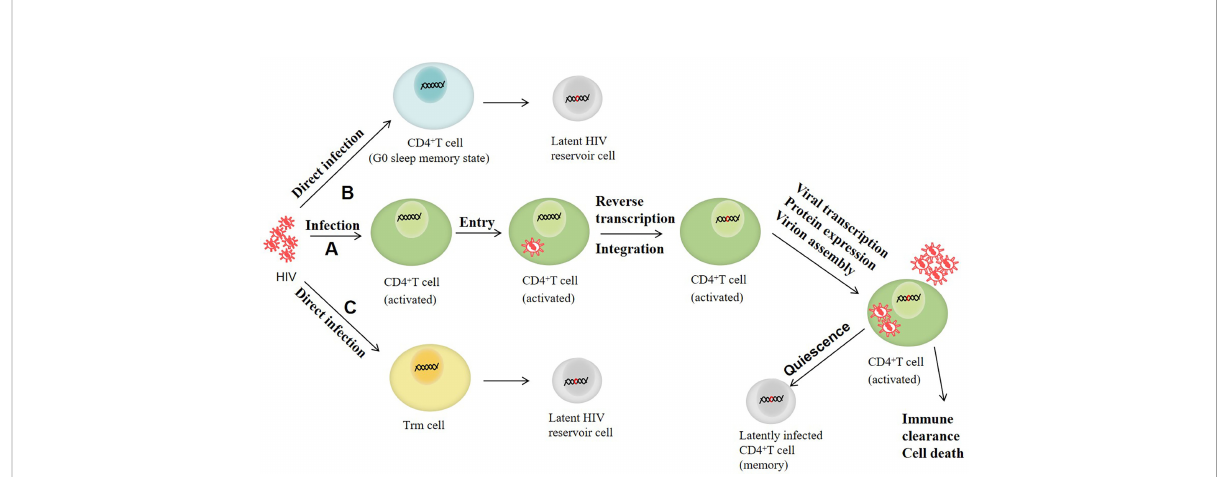
FIGURE 1 The formation process of latent HIV reservoir. (A) HIV mainly infects human CD4+T lymphocytes. When it enters the cell, the RNA is fi rst reversely transcribed into HIV DNA, which is then incorporated into the DNA of CD4+T cells. Some CD4+T cells with integrated HIV DNA are converted into a resting state, and the HIV in the resting CD4+T becomes latent HIV. (B) HIV directly infects CD4+T cells that revert to a G0 dormant memory state, thus enabling the virus to enter latency. (C) HIV establishes incubation by directly infecting resting memory CD4+T cells (Trm